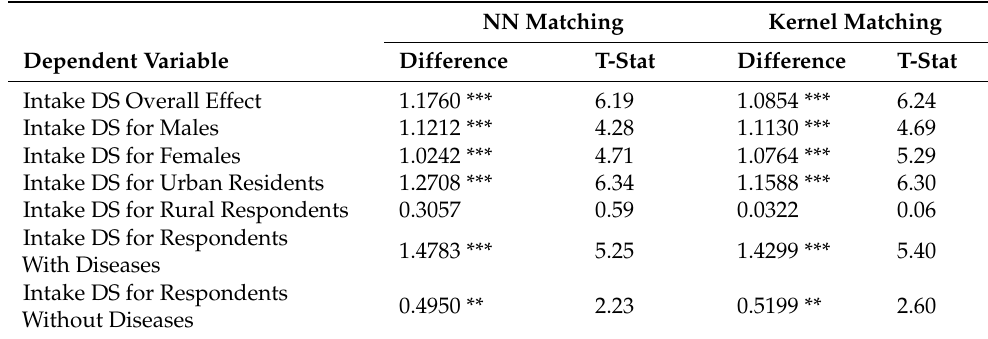
Table 5. Average treatment effects of intake of dietary supplements on the perceived health well-being. NN Matching Kernel